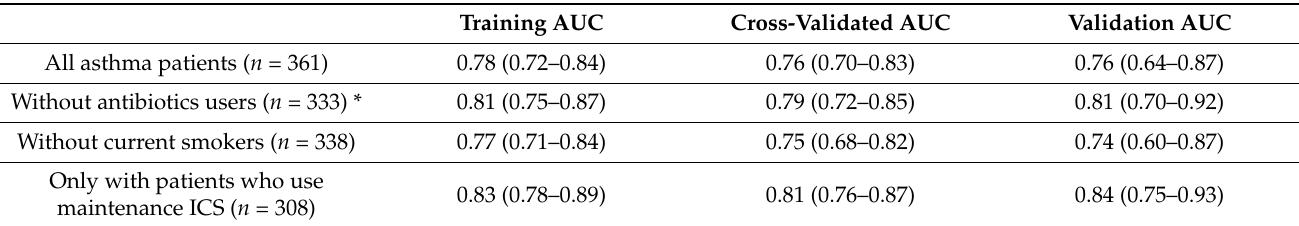
Table 3. Sensitivity analysis of the ability to discriminate between recent exacerbation and no-exacerbation in different